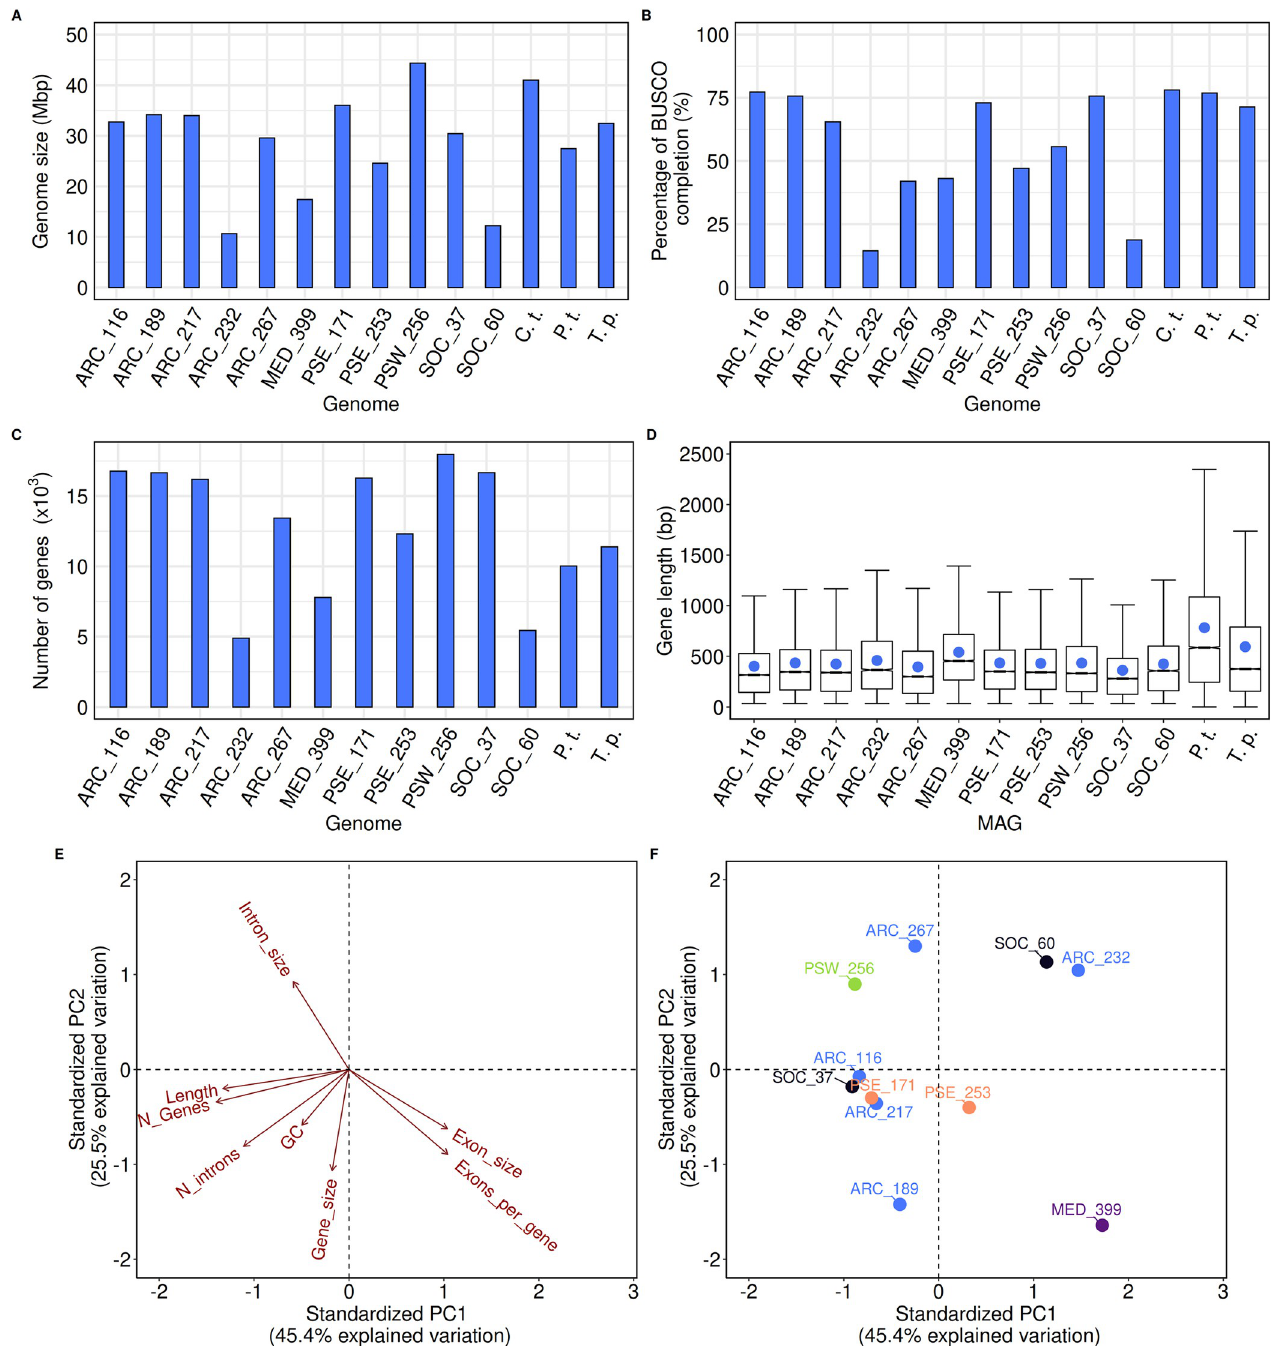
Fig 2. Characteristics of the different Chaetoceros MAGs. (A) Genome size, (B) level of BUSCO completion ( n = 255 BUSCOs), (C) number of genes, and (D) boxplots of mean gene length (mean gene length is represented by the blue dot) of the MAGs and reference diatoms C . tenuissimus (C.t.), P . tricornutum (P.t.), and T . pseudonana (T.p.). Only the assembly scaffolds of C . tenuissimus were available, preventing us from investigating the number of genes and their length. (E, F) PCA of different gene and genome metrics of the MAGs, shaded by geographical origin (blue: Arctic Ocean; purple: Mediterranean Sea; orange: Pacific South Eastern Ocean; green: Pacific South Western Ocean; black: Southern Ocean) (See Tables B and C in S1 Table for raw values). BUSCO, Benchmarking Universal Single-Copy Orthologs; MAG, metagenome-assembled genome; PCA, principal component analysis.